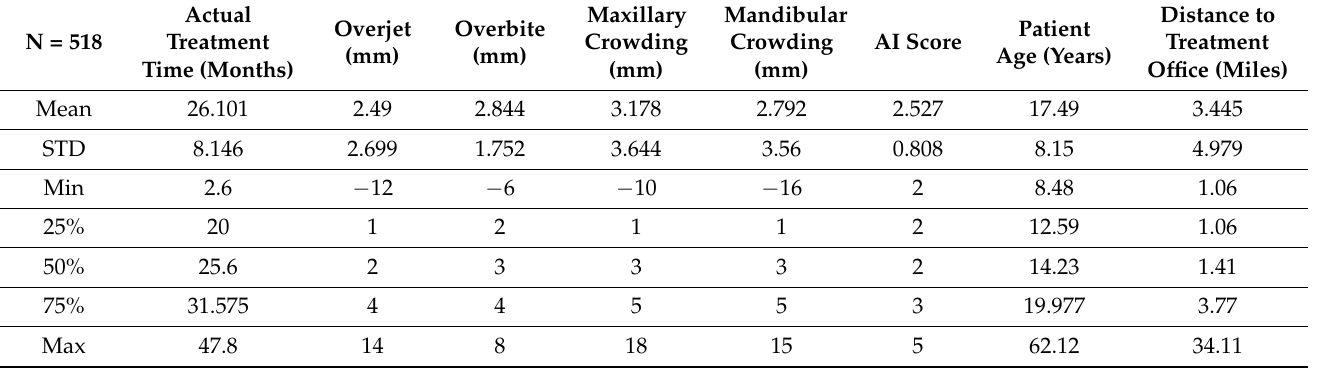
Table 1. Description of Patient Demographic Data.